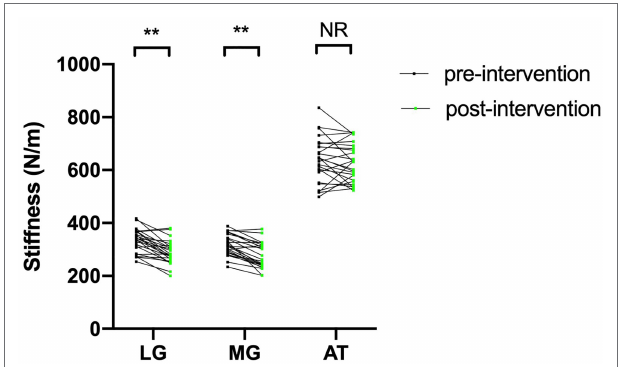
FIGURE 2 | The change in stiffness of the LG, MG, and AT in the FR group before and after foam roller intervention. FR, foam roller; MG, medial gastrocnemius; LG, lateral gastrocnemius; and AT, Achilles tendon; ** p < 0.01. NS, nonsignificant at p >